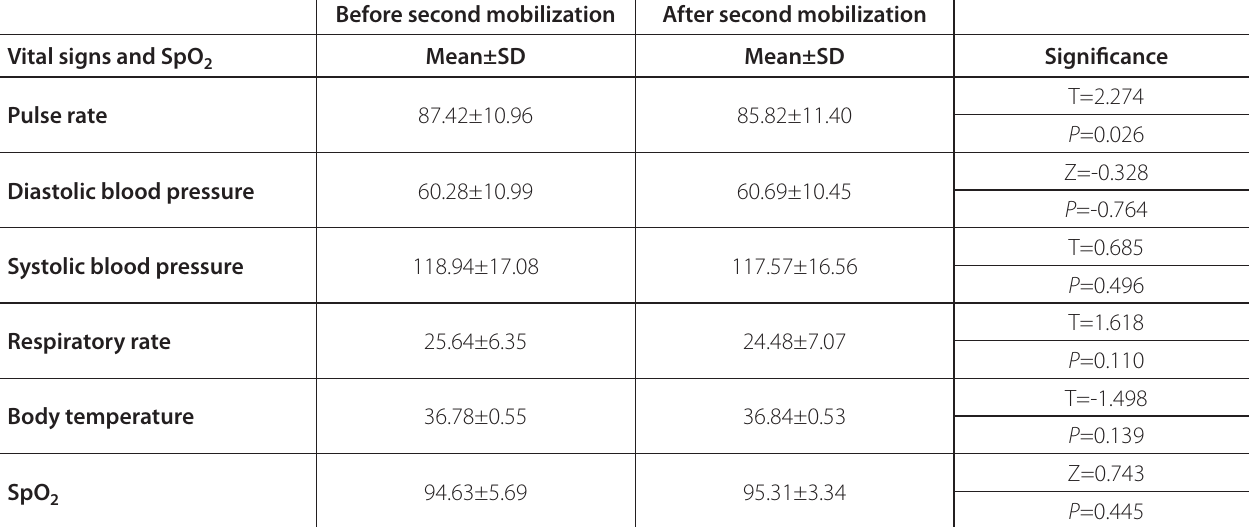
Table 3 . Comparison of vital signs and oxygen saturation levels obtained before and after the second mobilization session